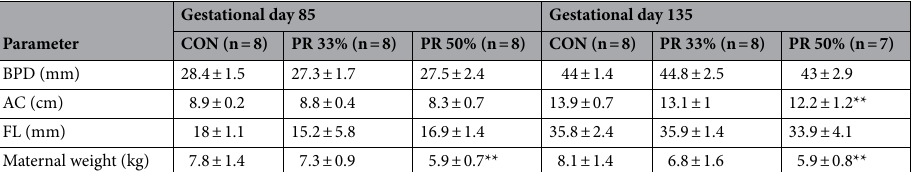
Table 1. Fetal biometry and maternal weight. BPD biparietal diameter, AC abdominal circumference, FL femur length. One-way ANOVA. Data are means ± SD. **p < 0.01.